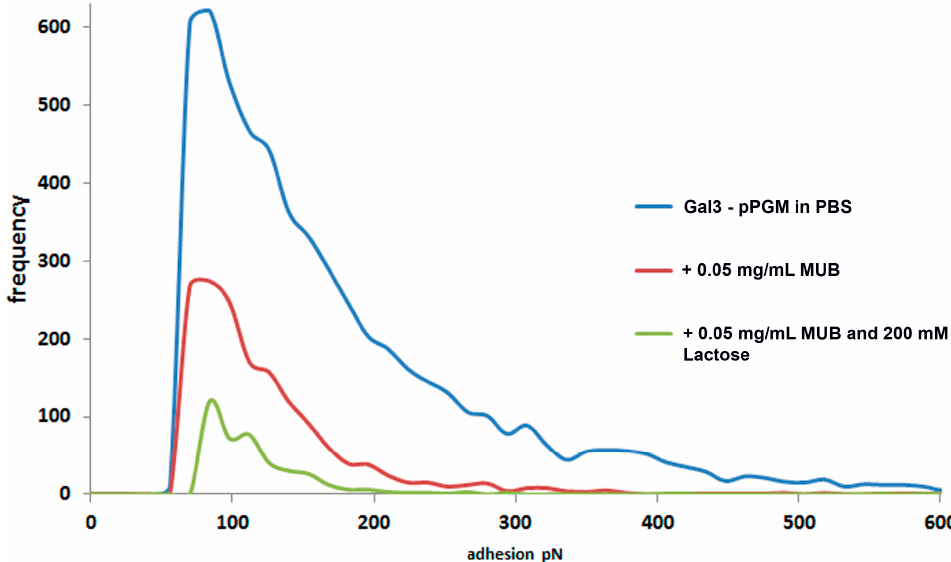
Figure 8. Interaction between Gal-3 and pPGM in the presence of MUB. Histogram quantifications illustrating the effects on the interaction between Gal-3 and pPGM following addition of free MUB and lactose into the solution.